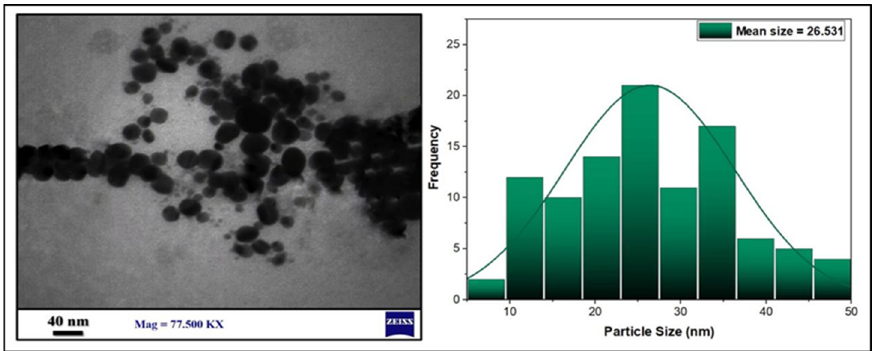
Figure 6. TEM images and histogram of the AgNPs particle size distributions.